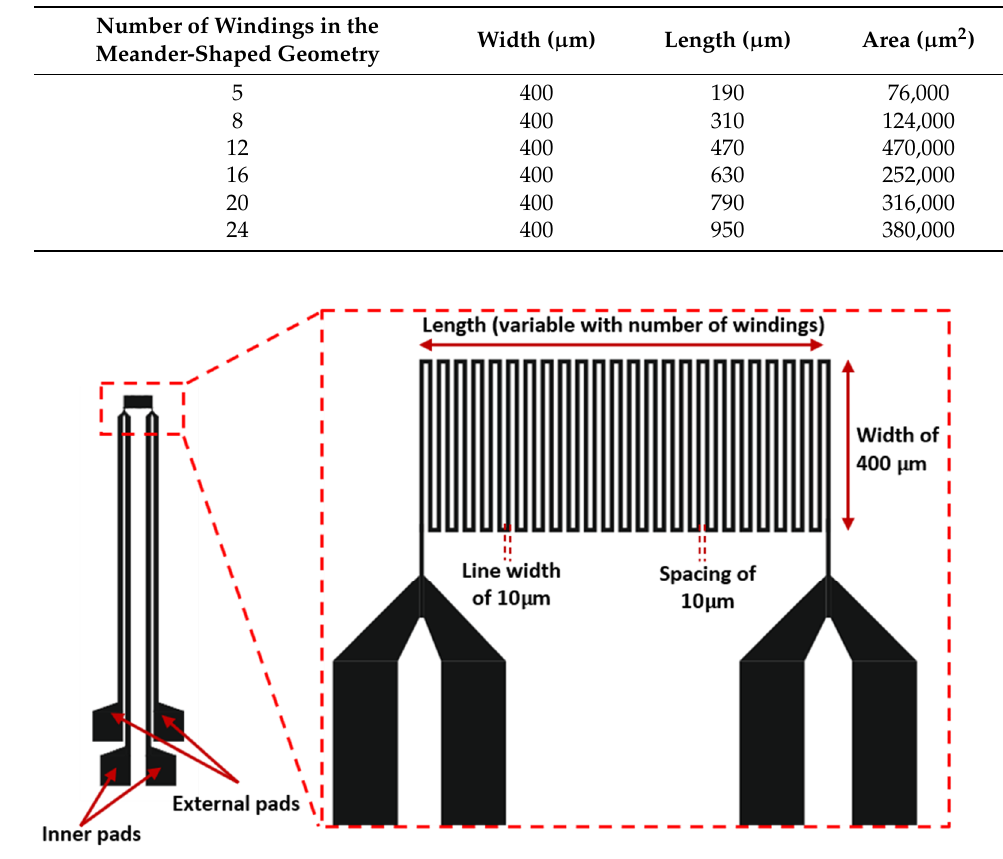
Figure 2. Schematic representation of the overall geometry of the temperature microsensors.